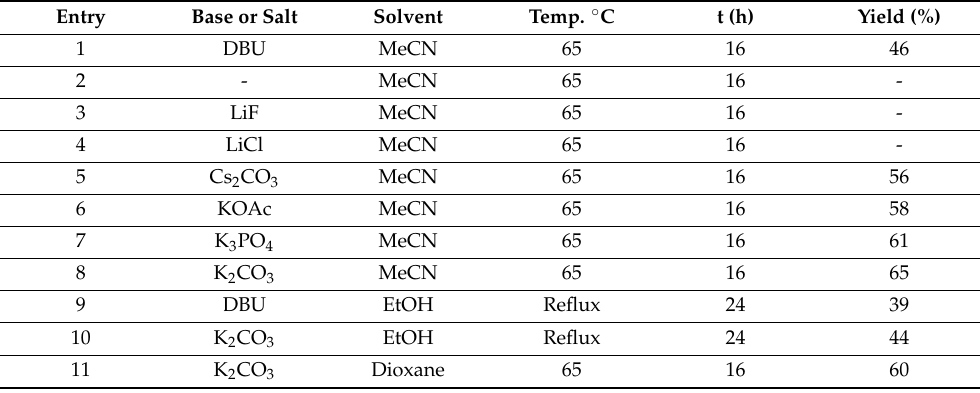
Table 1. Optimisation of reaction conditions of compound 4q